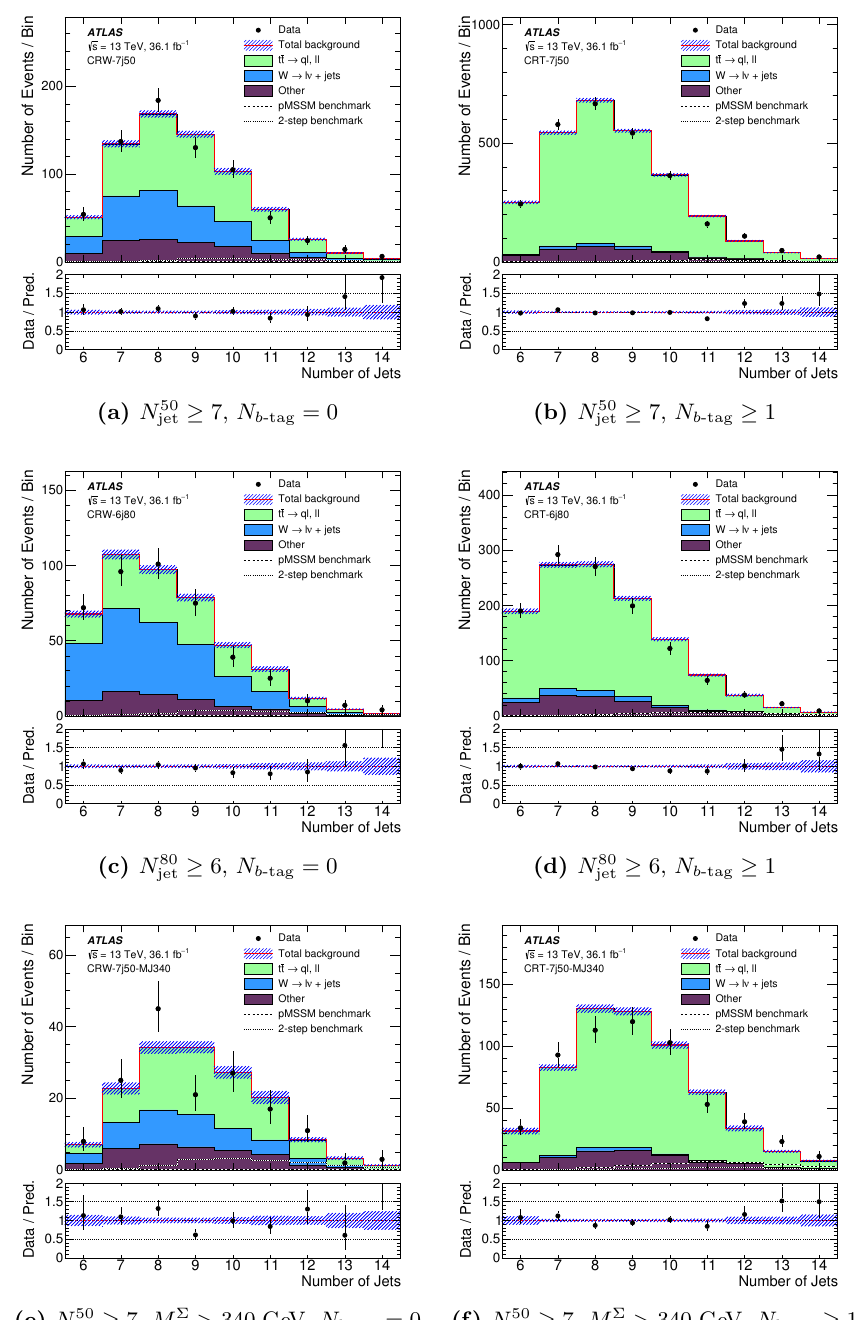
Figure 3. The distribution of the number of jets observed in the W +jets (left) and t (cid:22) t (right) control regions with the lowest jet multiplicities. The backgrounds are scaled by the normalisation factors extracted from the (cid:12)t, described in section 6.3. The blue hatched band indicates the statistical uncertainty from MC simulated samples. The dashed lines labelled ‘pMSSM’ and ‘2-step’ refer to benchmark signal points | a pMSSM slice model with ( m ~ g ; m ) = (1400 ; 200) GeV and a cascade ~ (cid:31) (cid:6) 1 decay model with ( m ~ g ; m ) = (1400 ; 200) GeV. The lower panels show the ratio of the observed ~ (cid:31) 0 1 data to the total SM